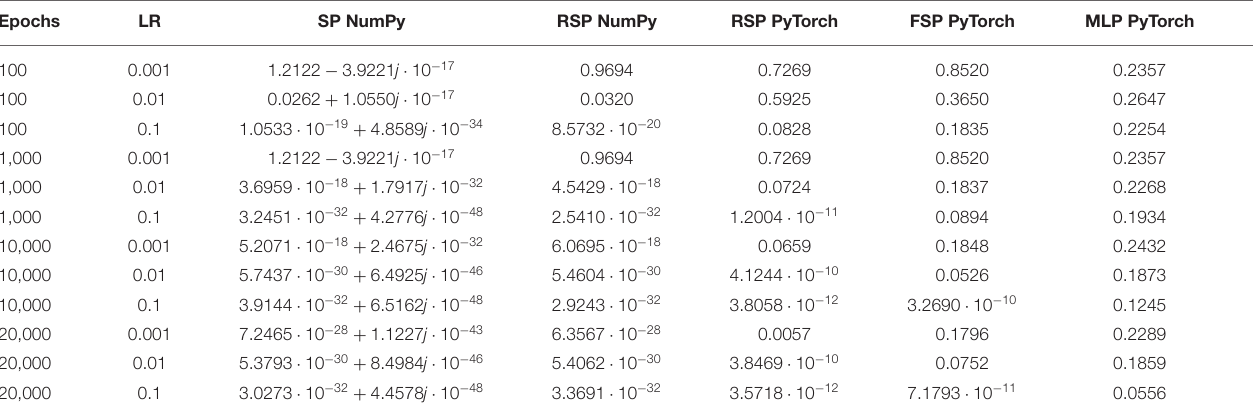
TABLE 8 | Measuring final loss when learning all 16 functions of the binary Boolean function Space, using different implementations of the signal perceptron and MLP with one hidden layer. Epochs